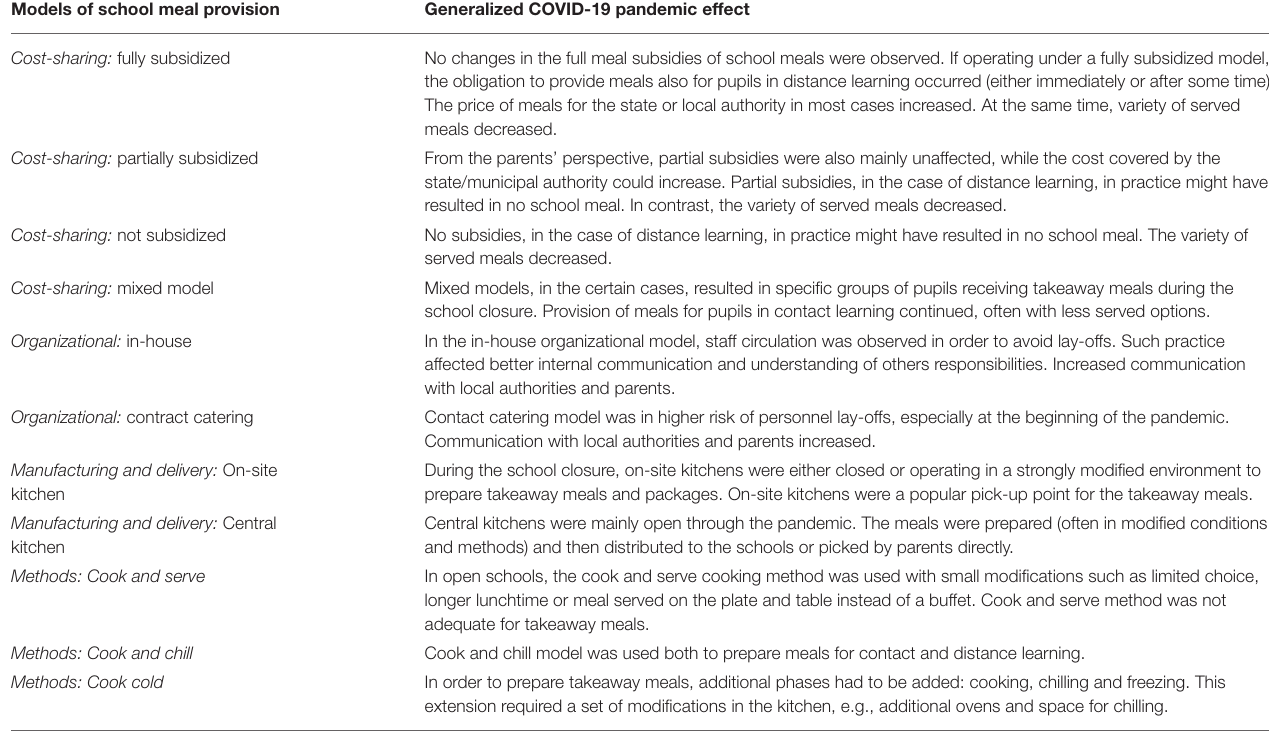
TABLE 8 | COVID-19 pandemic effects on regulatory and organizational models of school meal provision. Models of school meal